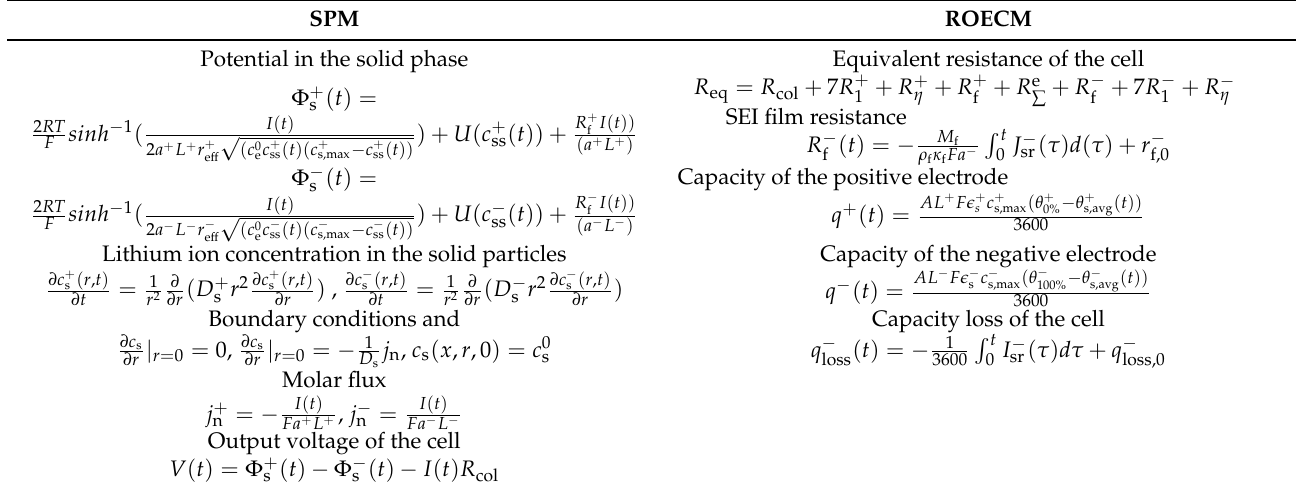
Figure A2. Reduced-order equivalent circuit model (ROECM) of the Li-ion battery showing the main and the side reactions circuits [8]. Table A1. Model Equations.